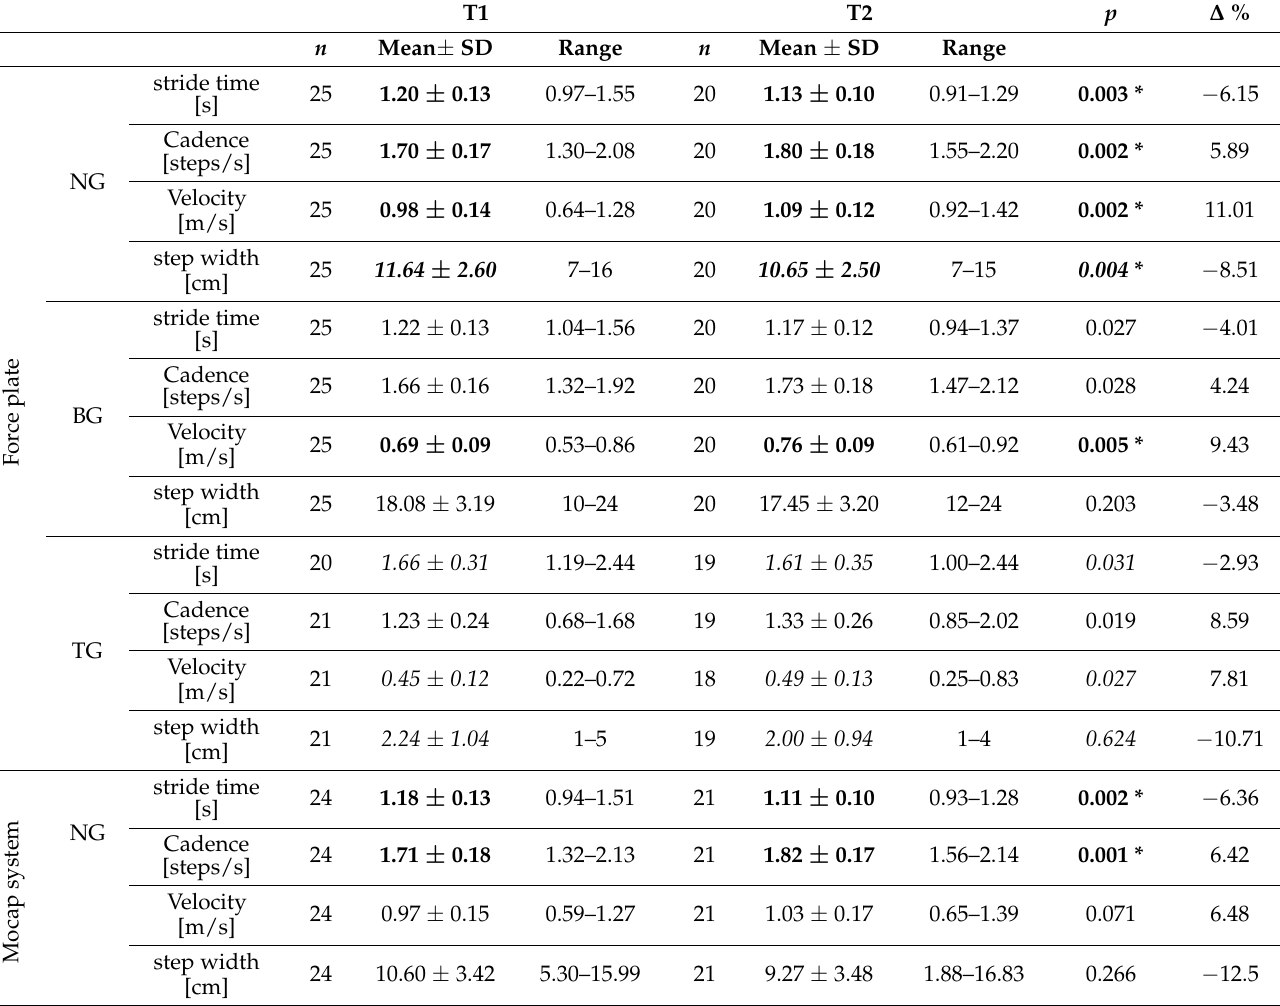
Table A1. Differences in mean between the first (T1) and second study visit (T2) for the gait variables of all three gait analysis systems. The percentage change is indicated in “ ∆ %”. Bold font indicates a significant difference in time (T1-T2, p < 0.013 for the force plate and mocap systems, p < 0.017 for smartphone) and bold plus italic font indicates a difference in time in the Wilcoxon rank test ( p < 0.013/ p < 0.017). Italic font indicates the implementation of a Wilcoxon rank test. An asterisk marks all significant values in general. Min. = minimum, max. = maximum, SD = standard deviation. T1 T2 p ∆ %